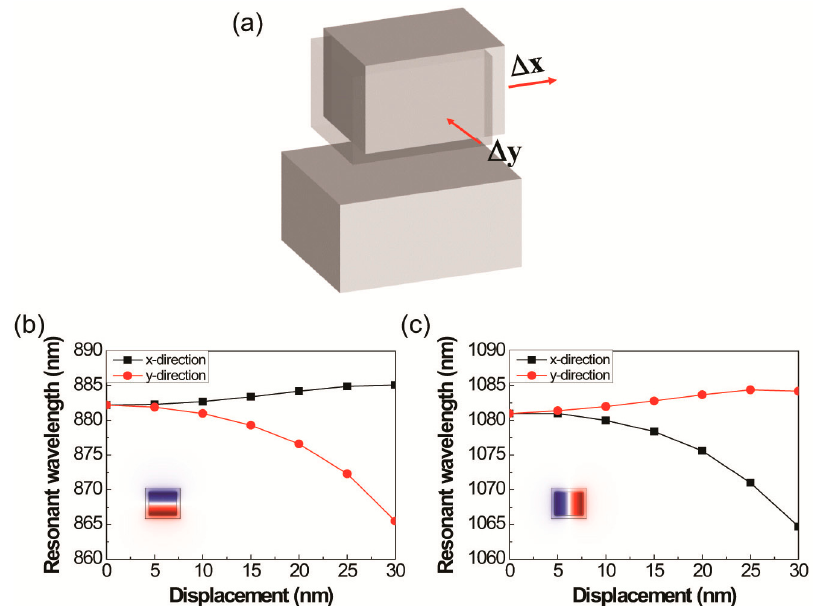
Figure 3. ( a ) Lateral movement of a small upper nanoblock, indicated by Δ x and Δ y . A transparent grey box represents an original upper block with no movement. The resonant wavelengths of the ( b ) M1 and ( c ) M2 as functions of x - (black) and y - (red) displacements of the cavity with a fixed air gap size of 10 nm. Insets show the mode profiles of M1 and M2 in the cavity with no movement.